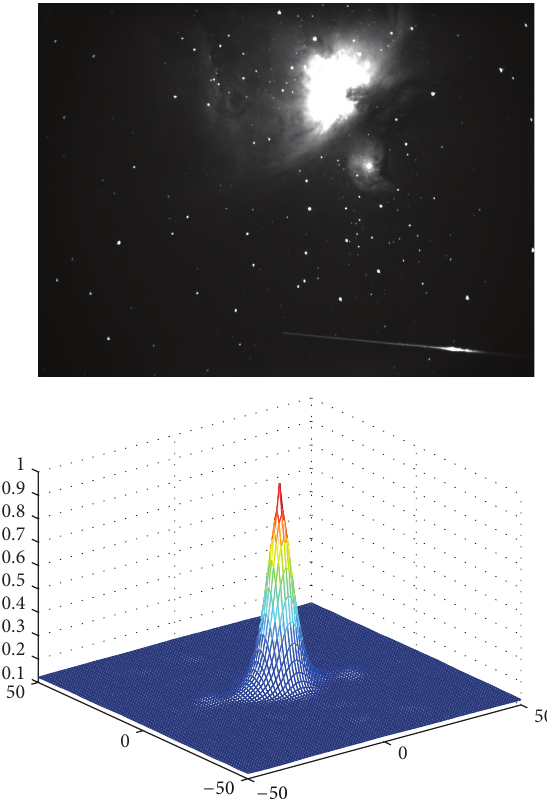
Figure 3: M42 nebulae with a satellite tray. Deep sky image from the BOOTES project (1024 × 1536 × 16bits) with its autocorrelation function.